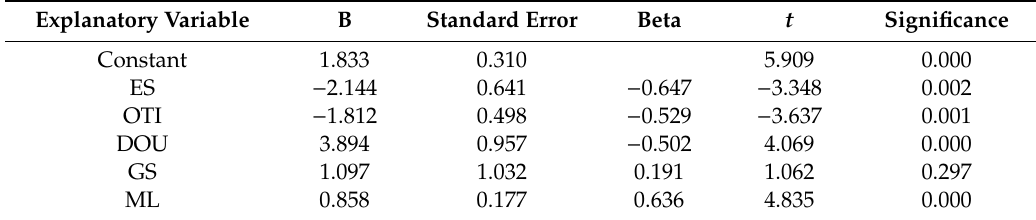
Table 7. The results of Tobit